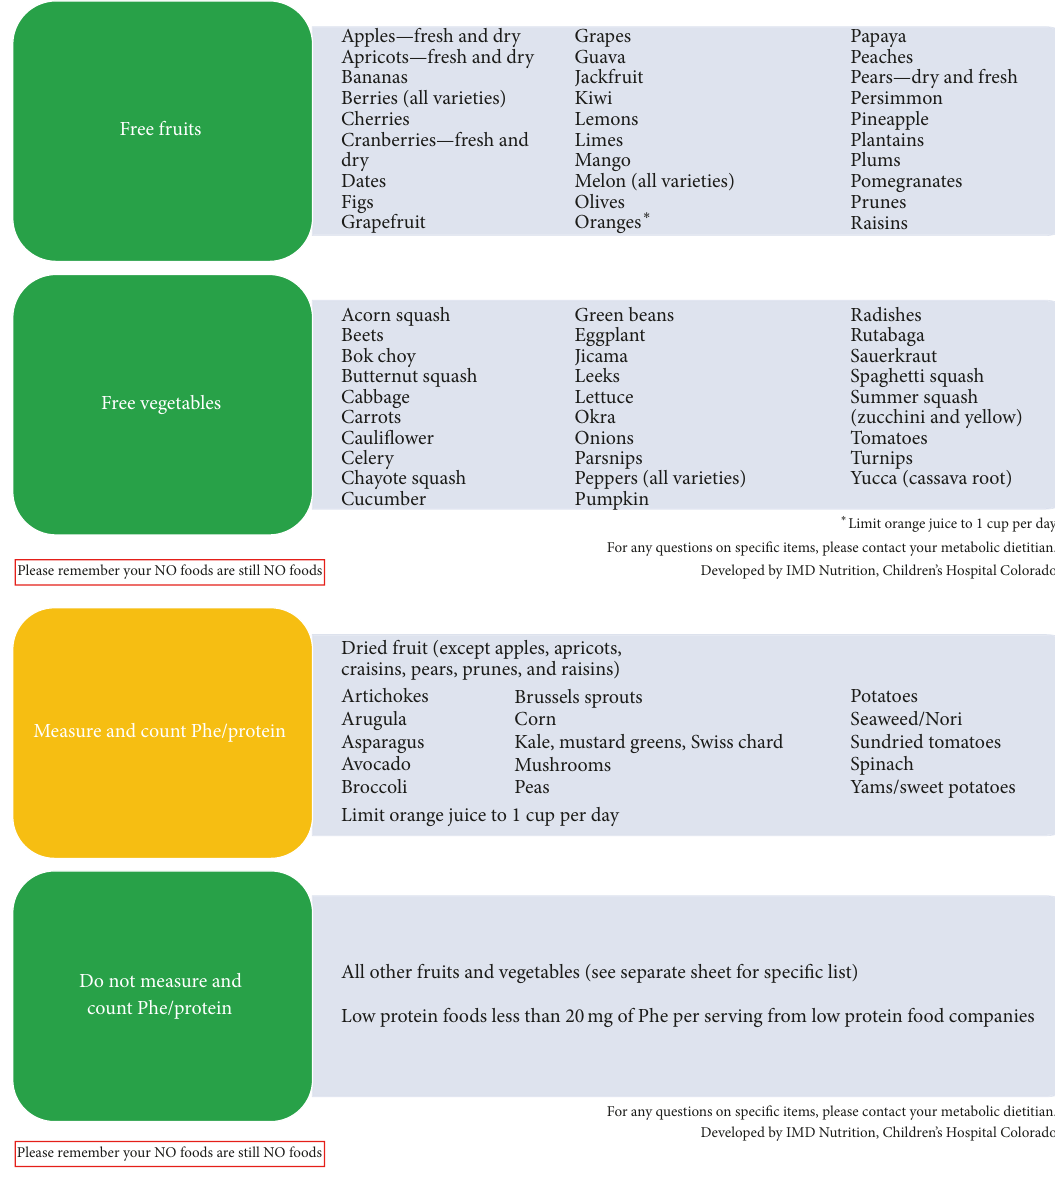
Figure 1: Simplified PKU diet; Inherited Metabolic Diseases Clinic, Children’s Hospital